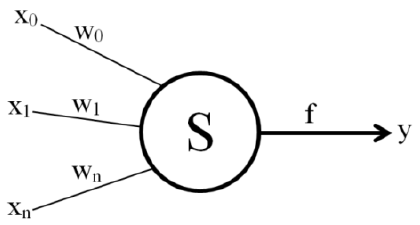
Figure 1. Neuron mathematical model.